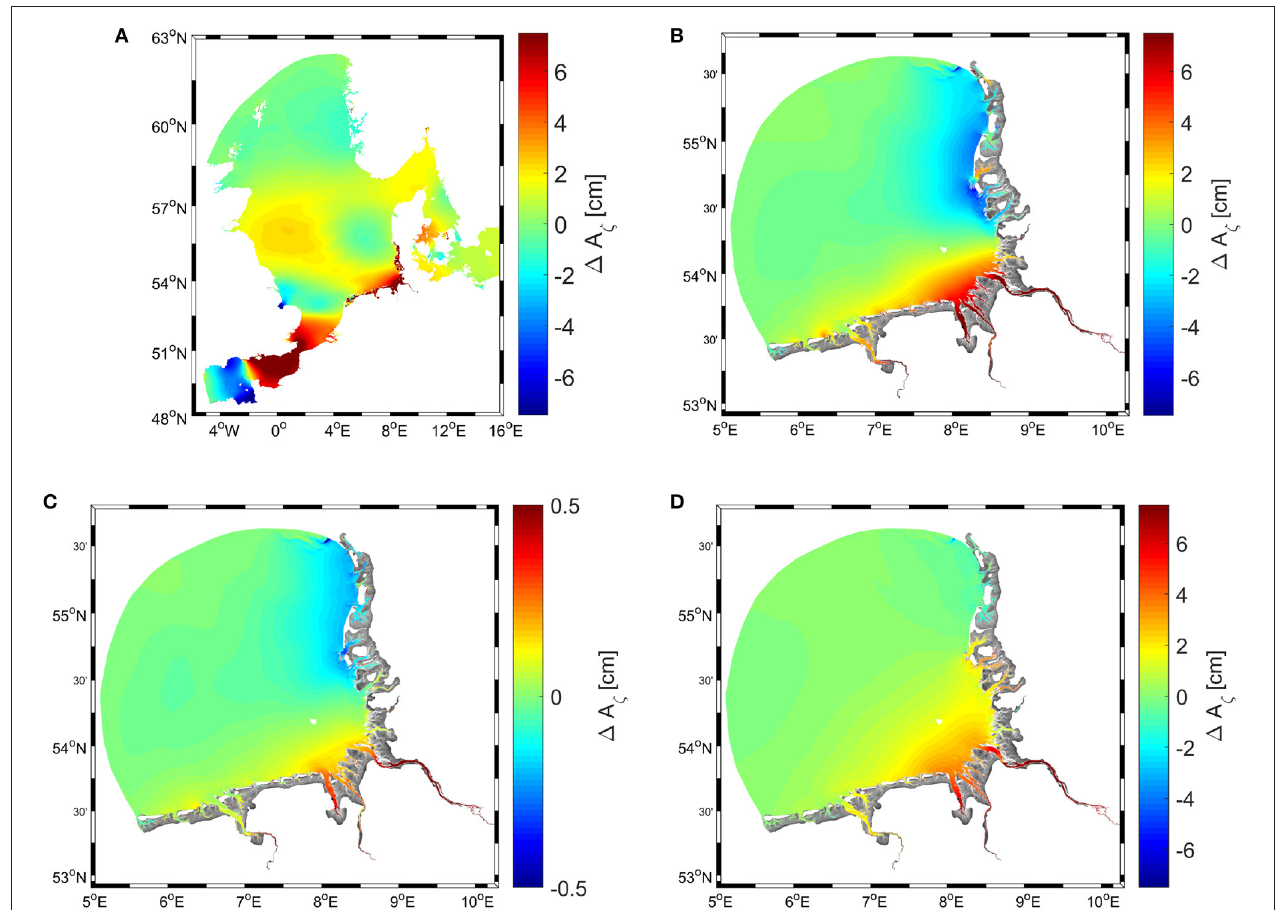
FIGURE 5 | Differences in SSH between the NS-SLR-2 and NS-1982 experiments. Amplitudes are measured as the standard deviation of SSH in the individual experiments during two neap/spring tidal cycles. (B) Is the same as (A) but for the German Bight; here, the comparison is between experiments GB-SLR-2 and GB-1982. (C) Comparison of the amplitudes in GB-SLR-006 and GB-1982. (D) Difference between the amplitudes in GB-2012 and